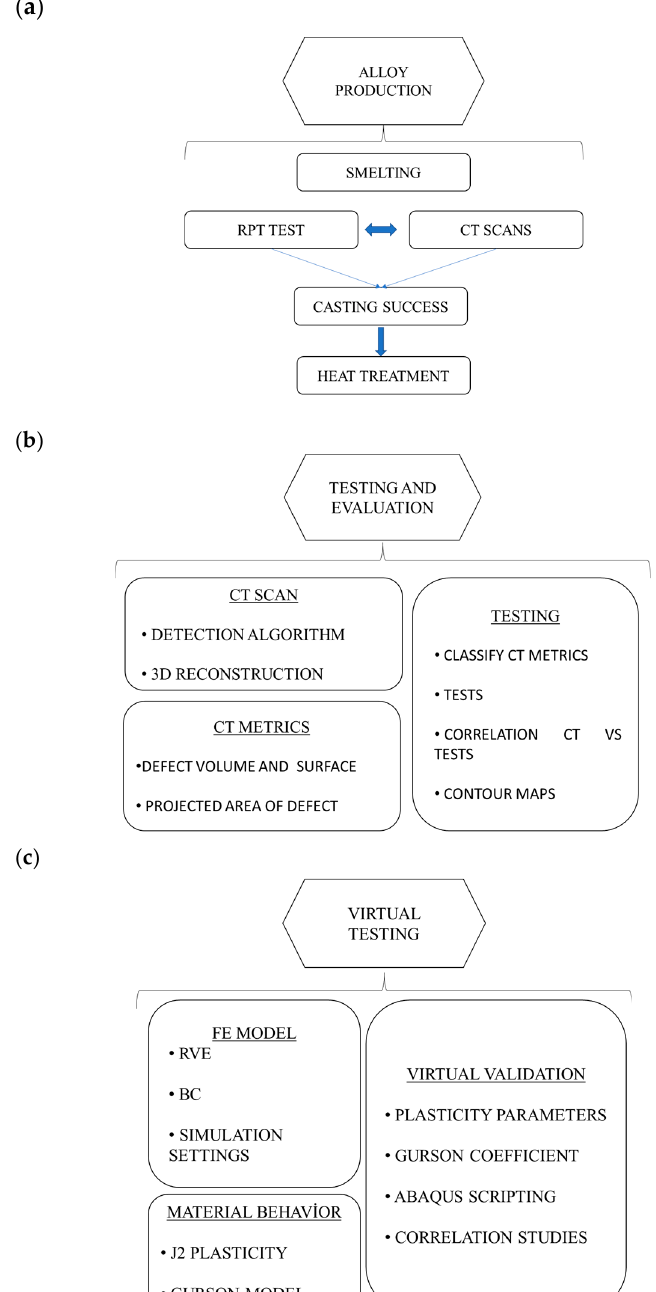
Figure 1. Study Flow Chart as ( a ) Production ( b ) Testing ( c ) Virtual Validation.